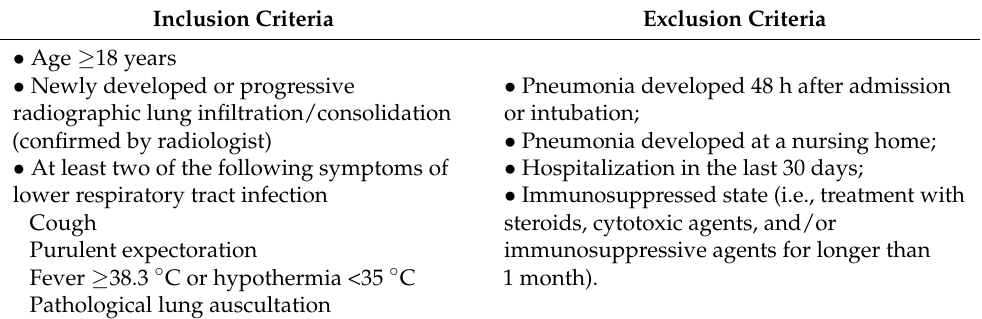
Table 1. Inclusion and exclusion criteria of community-acquired